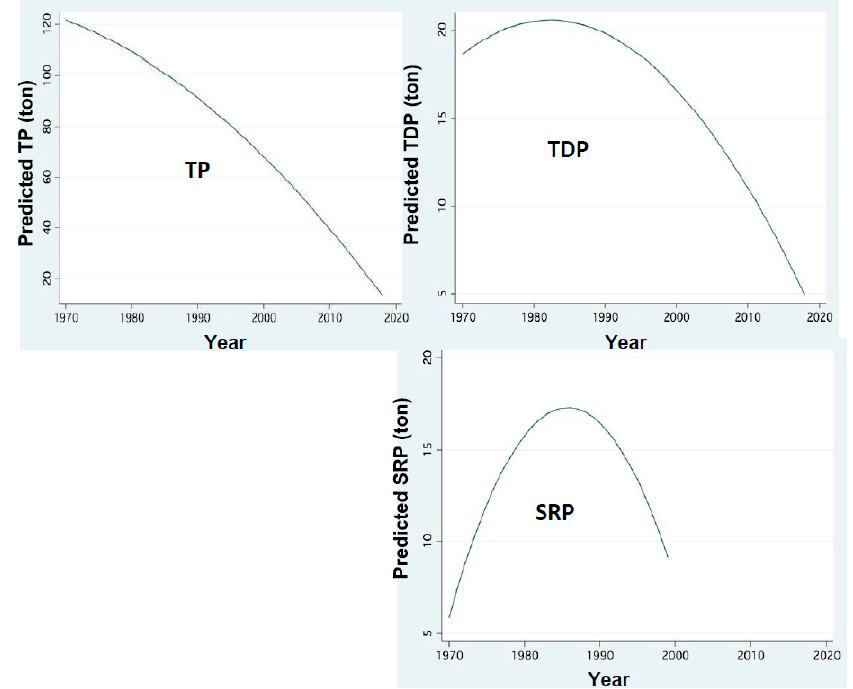
Figure 5. Temporal changes of P loads:FP regression between annual (1970–2018) Load inputs (ton) through Jordan discharge of Total Phosphorus (TP),Total Dissolved Phosphorus (TDP) and Soluble Reactive Phosphorus (SRP) and years.